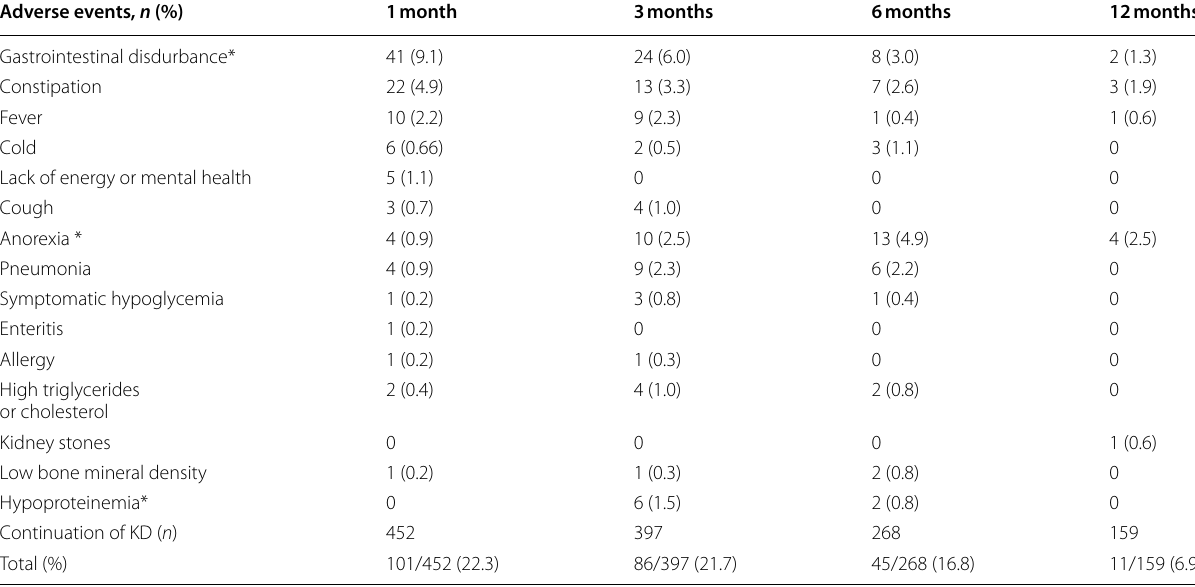
Table 4 Adverse events in patients with infantile spasms at different time points of follow-up Adverse events, n (%)